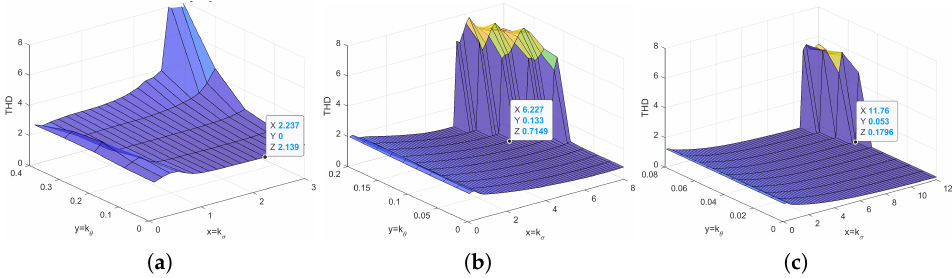
Figure 5. Surfaces of THD values as functions of k θ and k σ for three sampling rates: ( a ) f s = 12.8 kHz, ( b ) f s = 25.6 kHz and ( c ) f s = 51.2 kHz. The optimum values ( k 0 σ , k 0